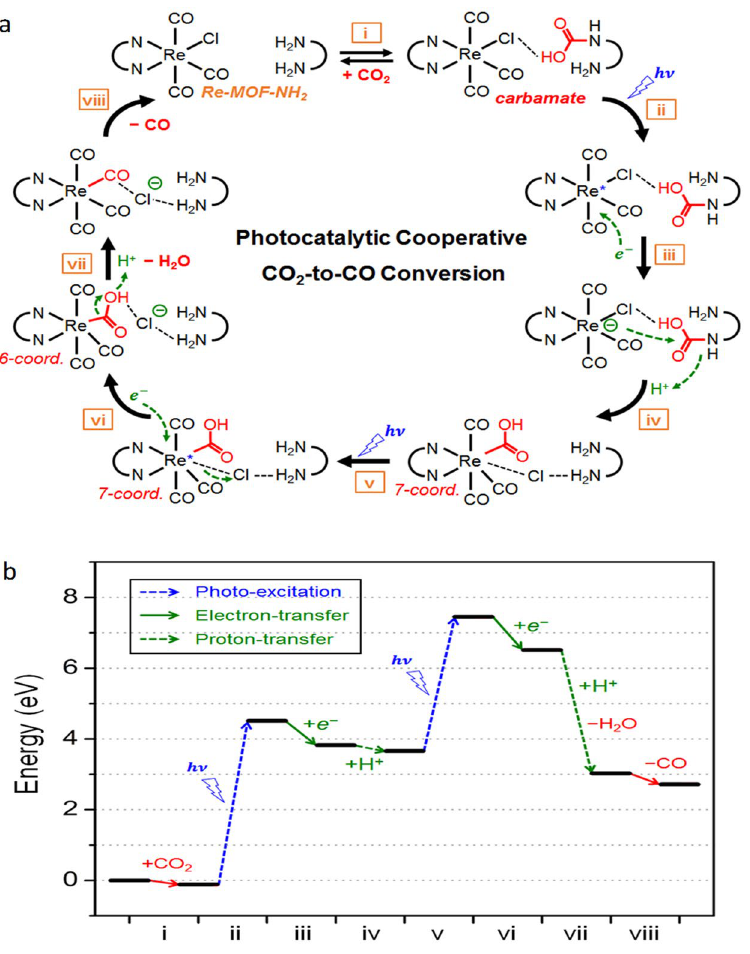
Figure 5. Proposed amine-assisted synergetic photocatalytic conversion mechanism of CO 2 into CO based on DFT energetics. ( a ) The reaction paths for photocatalytic conversion of CO 2 into CO; (i) the carbamate formation, (ii) the 1 st photo-excitation, (iii) the 1 st electron transfer from TEA, (iv) the nucleophilic attack of Re to COOH accompanied with the 1 st proton transfer from TEA + , (v) the 2 nd photo-excitation, (vi) the 2 nd electron transfer from TEA, (vii) the H 2 O formation accompanied with the 2 nd proton transfer from TEA + , and (viii) the CO formation. ( b ) The calculated energies from stage i to stage viii. The results demonstrate that the production of CO upon absorption of two photons in visible light is energetically favorable in the presence of the –NH 2 ligand and the ReTC ligand in the neighboring